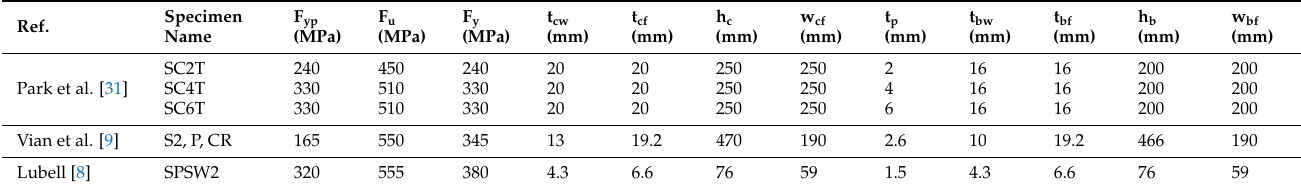
Table 1. Geometrical dimensions of structural sections and mechanical properties of materials.